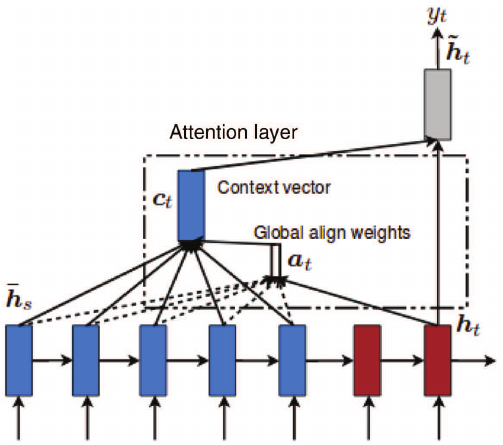
Figure 1: LSTM Decoder Using Context Vector and Current Hidden State for Translation Prediction.